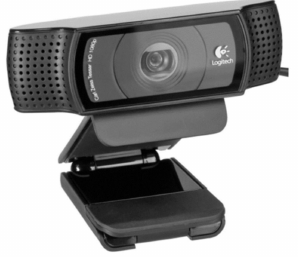
Figure 8. Logitech C920 HD Pro web